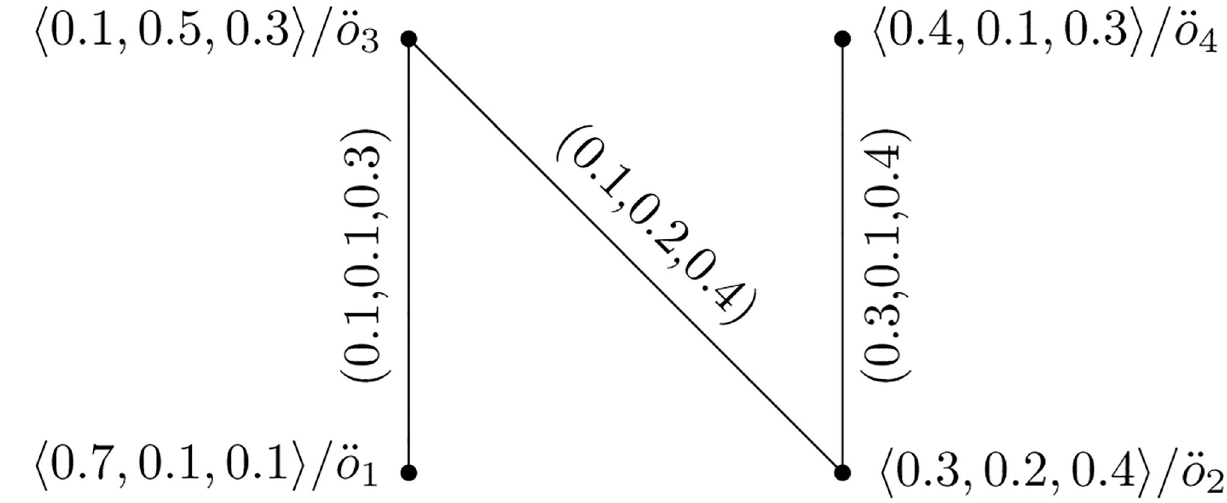
Fig 2. Picture fuzzy hypersoft graph Y